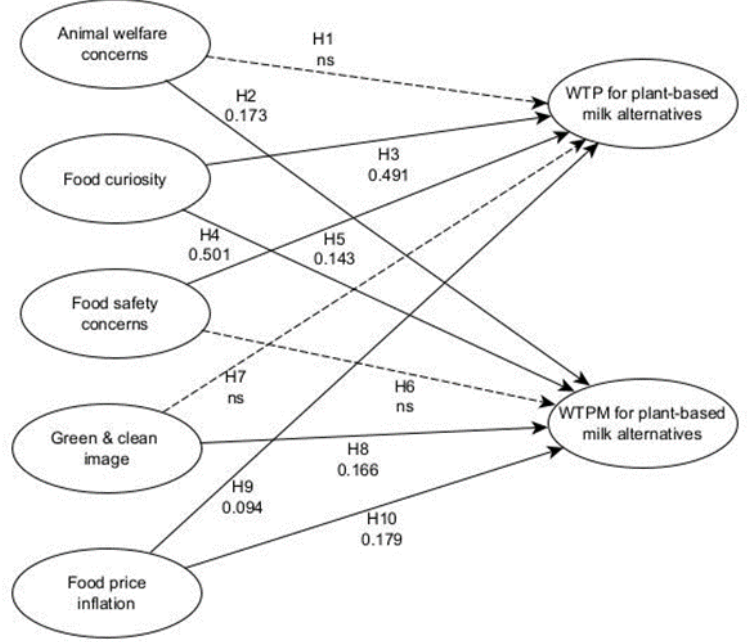
Figure 2. Results. Note: WTP: Willingness to pay; WTPM: Willingness to pay more. Table 4. Results of hypothesis testing.